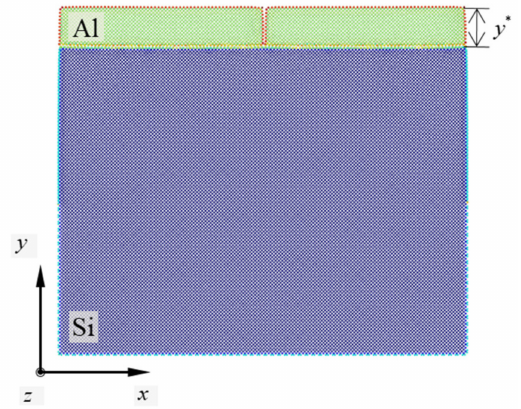
Figure 1. Representative simulation model as the minimum energy states. Si and Al are used as the substrate and nanofilm materials, respectively. The crystallographic orientations with respect to the interface plane of the materials are Al(110) and Si(010). The thickness of the Al nanofilm is approximately 3 nm. The vertical crack is located in the center of the Al nanofilm along the x